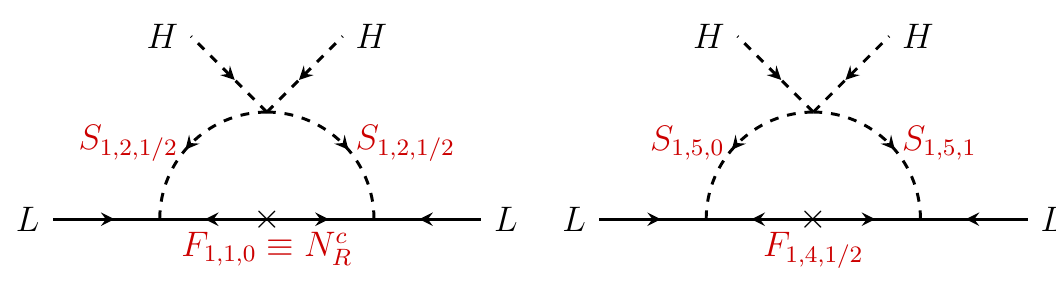
Figure 2 . Two examples of dark matter models. To the left the original scotogenic model [47]; to the right an accidentally stable DM model, see